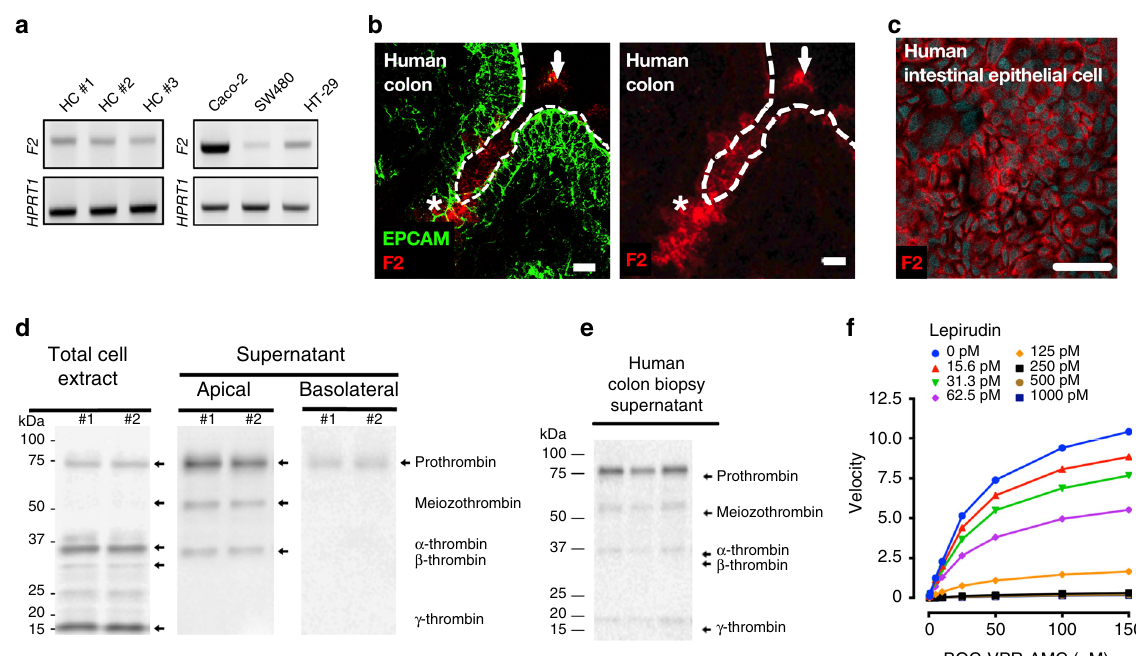
Fig. 1 Intestinal epithelium releases active thrombin in gut lumen. a F2 mRNA transcripts (Factor 2, thrombin) were detected in colonic crypt epithelium from three different healthy human (left), and three different human cancer cell lines (Caco-2, SW480 and HT-29, right). Representative blots from 3 independent experiments. b Immunostaining of Epithelial cell adhesion molecule (EPCAM, green, epithelial cell marker) and thrombin (red) in human colon biopsy displays thrombin-expressing epithelial cells (stars) and secreted thrombin in the lumen (arrows). Images are representative of three human donors. Scale bar corresponds to 20 µ m. c Immunostaining of thrombin (purple) and nuclei (cyan blue, 4 ′ ,6-diamidino-2-phenylindole or DAPI) con fi rmed the speci fi c staining of thrombin in Caco-2 cells. Images are representative of at least 3 independent fi elds. Scale bar corresponds to 50 µ m. d Western blots revealed the presence of prothrombin (72 kDa) and its active isoforms (50, 32, 28 and 15 kDa) in Caco-2 cell protein extract (left blot). Released thrombin quantity was higher in apical (middle blot) compared to basolateral media (right blot). Representative blots from 3 independent experiments. e Western-blot con fi rmed the presence of human prothrombin and its active isoforms in colonic biopsy supernatant from three healthy donors. Representative blot from 3 independent experiments f Caco-2 cultured for 24 h in serum-free medium releases a trypsin-like activity (boc-VPR-AMC fl uorescent substrate) that is dose-dependently inhibited by the thrombin inhibitor (lepirudin). Activity assay was reproduced in 3